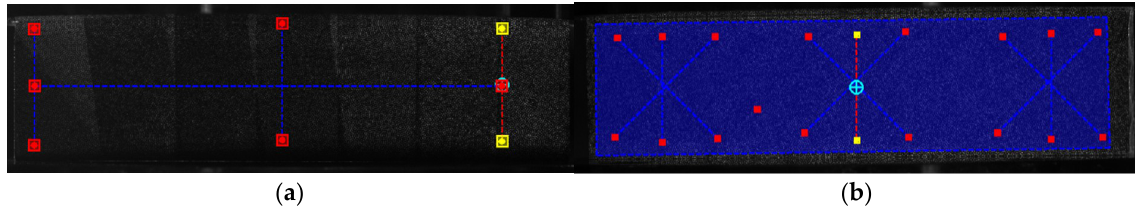
Figure 7. Virtual optical gauges ( a ) sample in CD; ( b ) sample in 45°. Using the tests for CD, ε yy (in the CD direction) and ε xx (in the MD direction) were measured from each image either by averaging large region from the DIC (see Figure 6b) or by using virtual extensometers: 3 vertical plus 1 horizontal (see Figure 7a). The front and back data were averaged to remove artificial bending data. A similar methodology was used in case of the ECT in a 45 ◦ direction. All stiffnesses, e.g., F yy vs. ε yy were calculated from the linear portion of the graphs.